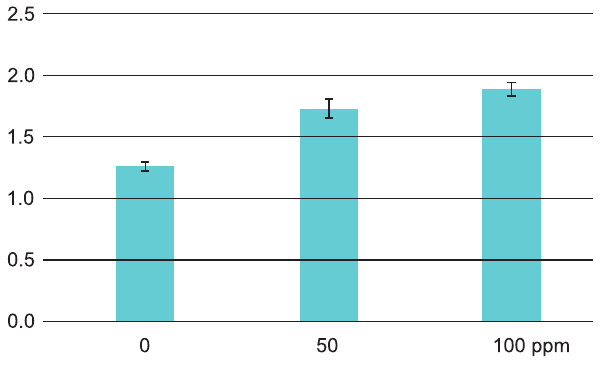
Fig 6. Evolution of the ATP content of a culture of E . coli (OD 600 = 0.2) incubated for 3 h in Seine river water under room light as a function of P25